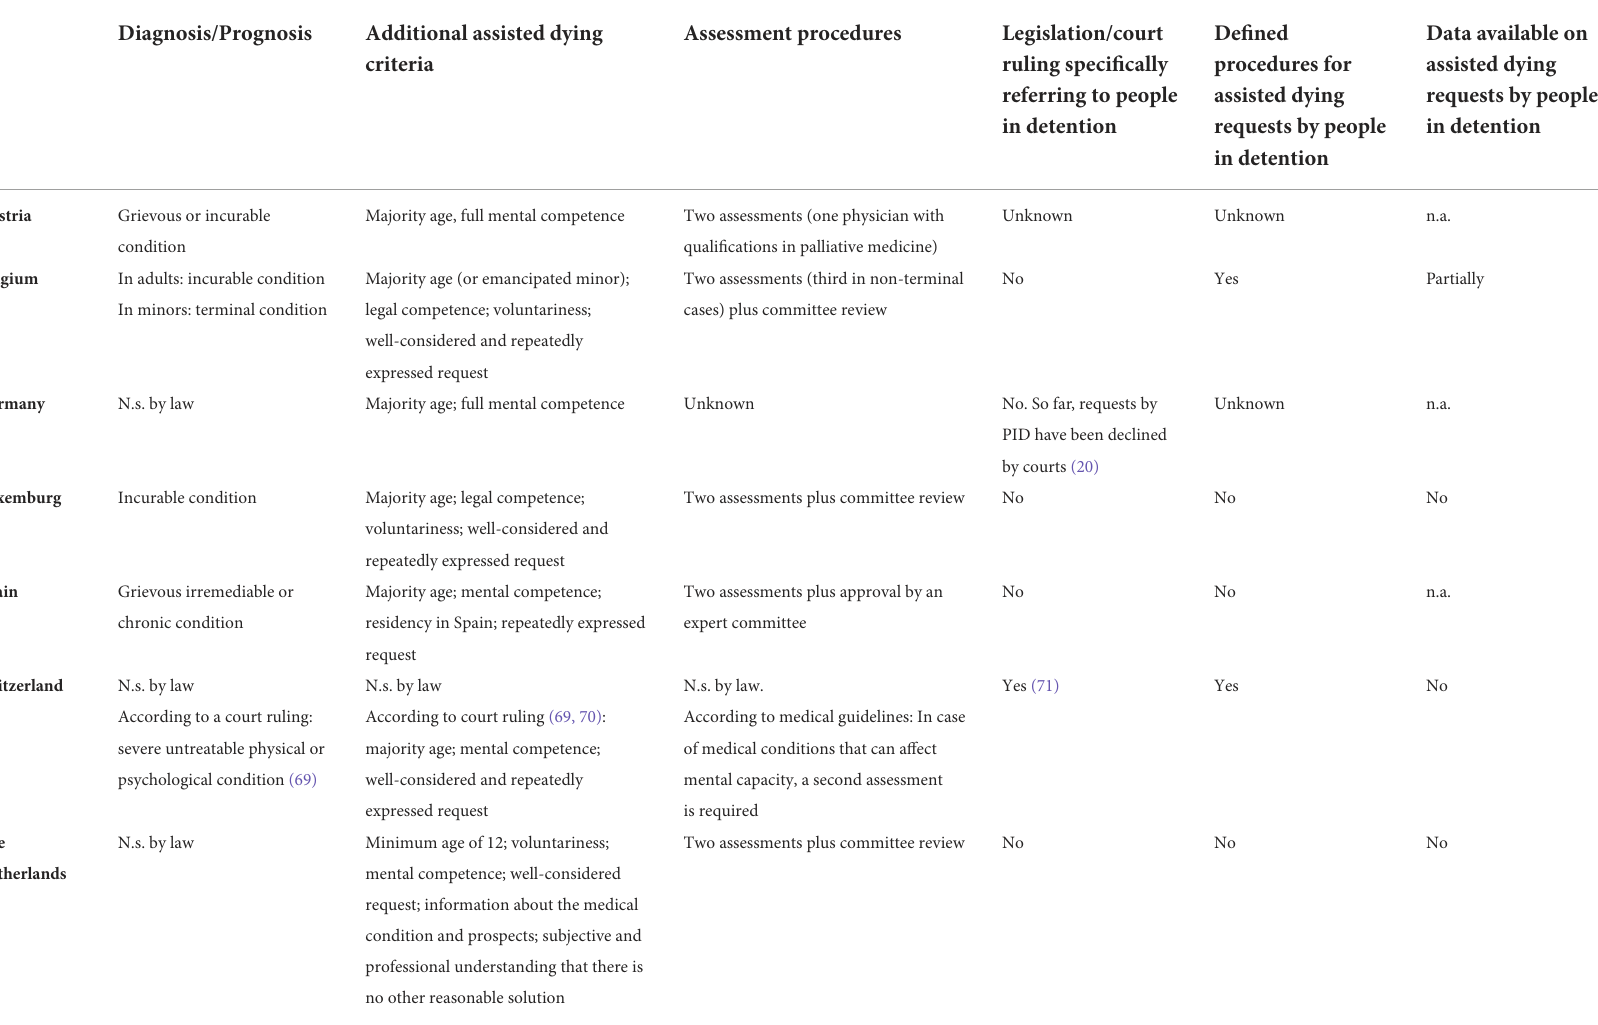
TABLE 1 Access to assisted dying for people in detention in countries that have decriminalized assisted dying [modified from (1,